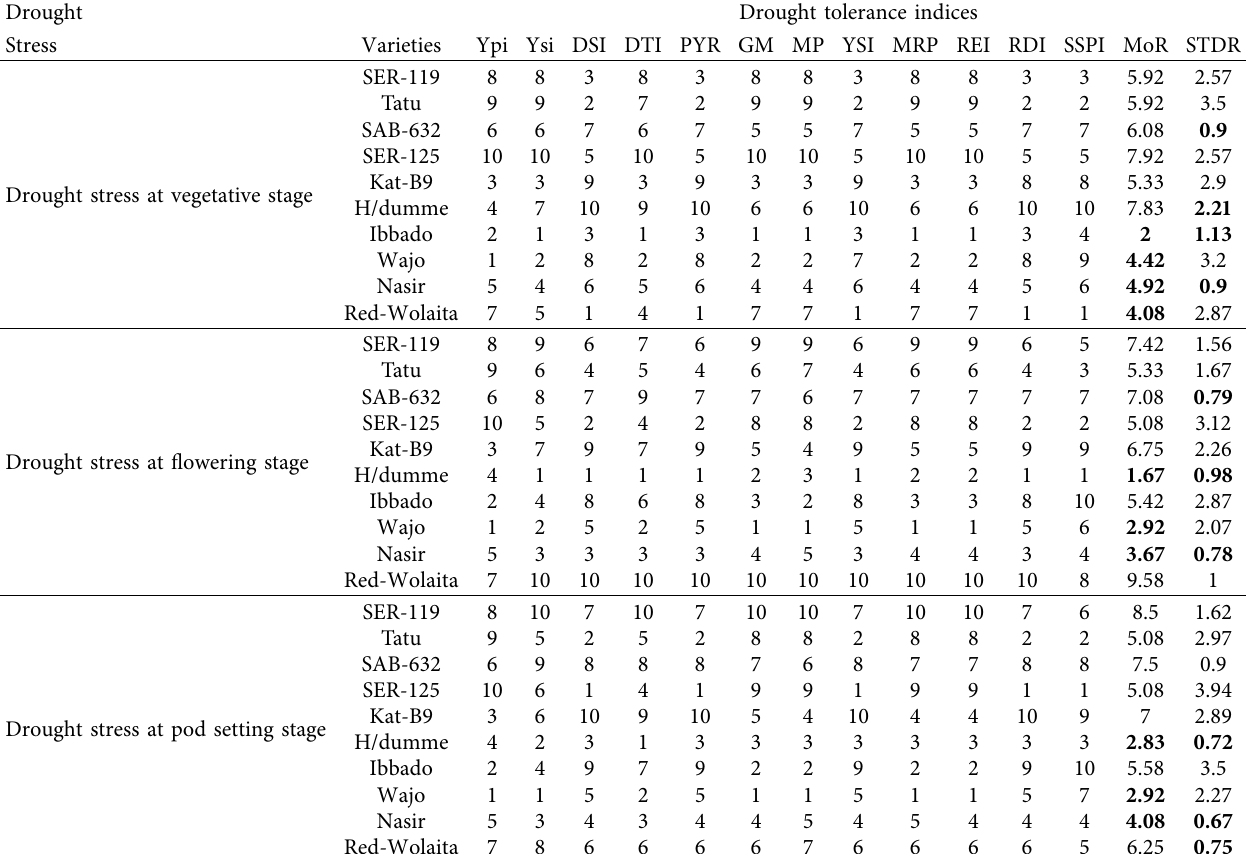
Table 4: Rank (R), mean of ranks (MoR), and standard deviation of ranks (STDRs) of drought tolerance indices of haricot bean varieties exposed to drought stress at different growth stages. Drought